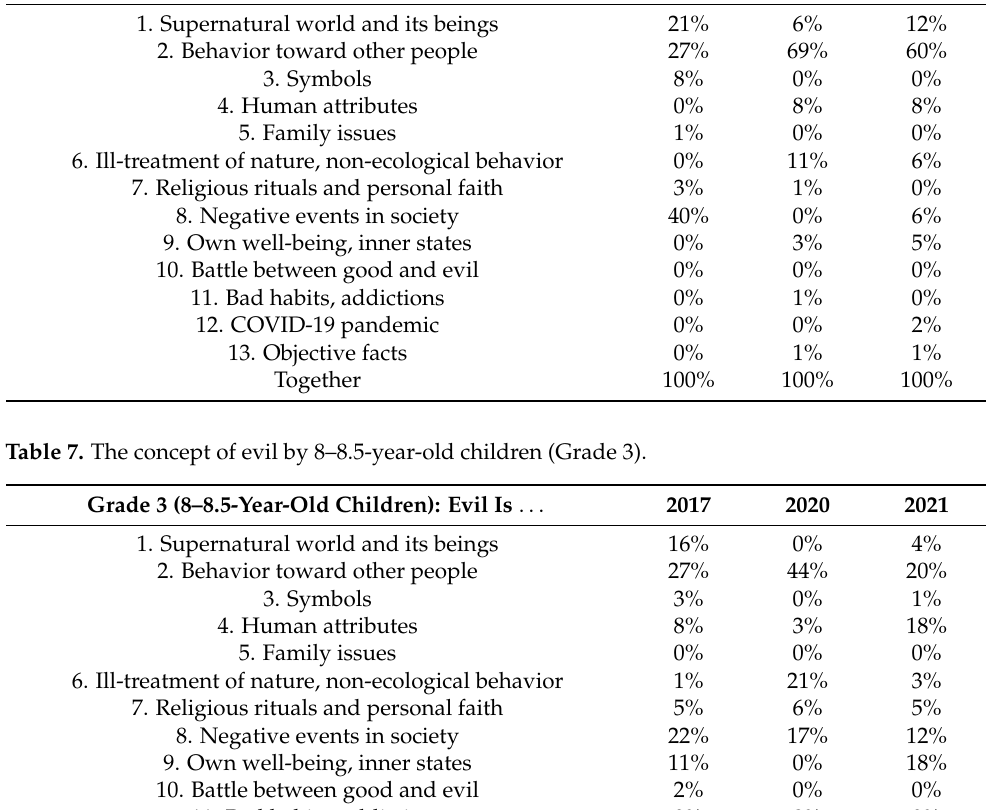
Table 6. The concept of evil by 7–8-year-old children (Grade 2). Grade 2 (7–8-Year-Old Children): Evil Is . . .